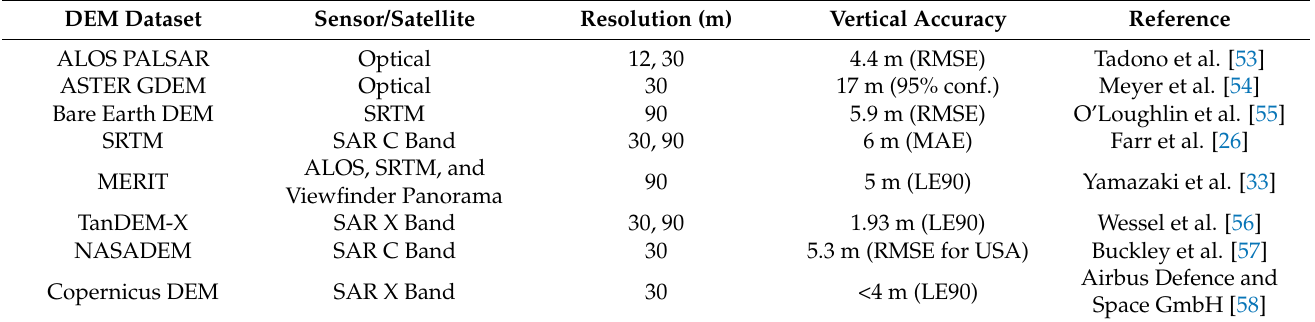
Table 2. Overview of free global DEMs used for peak flow modelling in Mocuba city